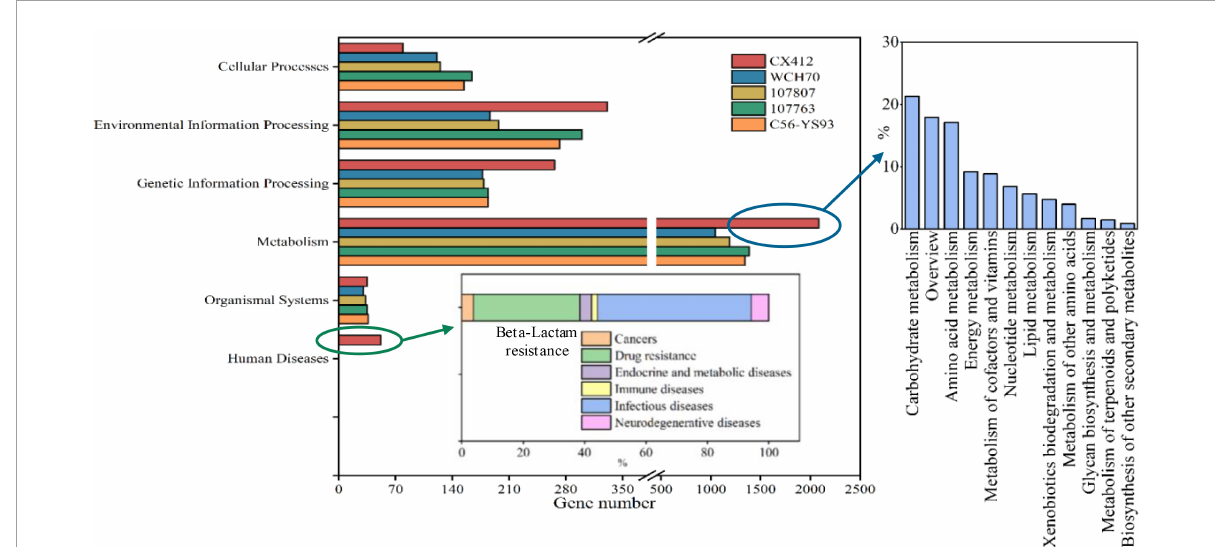
FIGURE4 KEGG Pathway categories histogram. CX412, Geobacillus sp. CX412; WCH70, Geobacillus sp. WCH70; 107807, Parageobacillus toebii NBRC 107807; 107763, Parageobacillus thermoglucosidasius NBRC 107763; C56-YS93, Parageobacillus thermoglucosidasius C56-YS93.